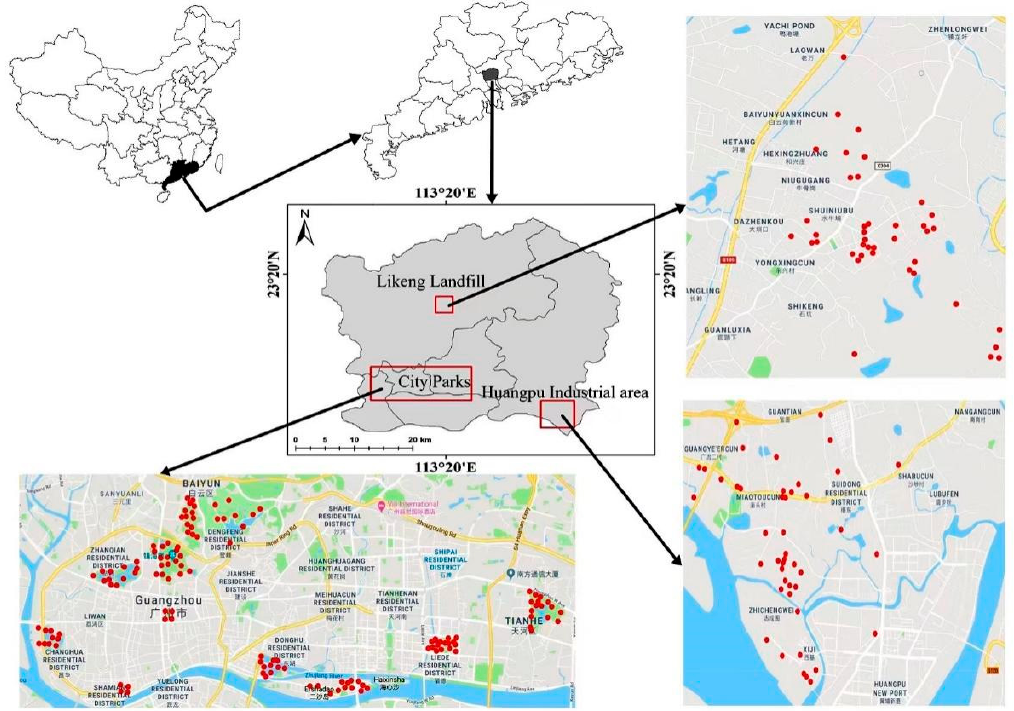
Figure 1. Location of the study area and distribution of sampling sites. Red dots represent sampling sites.